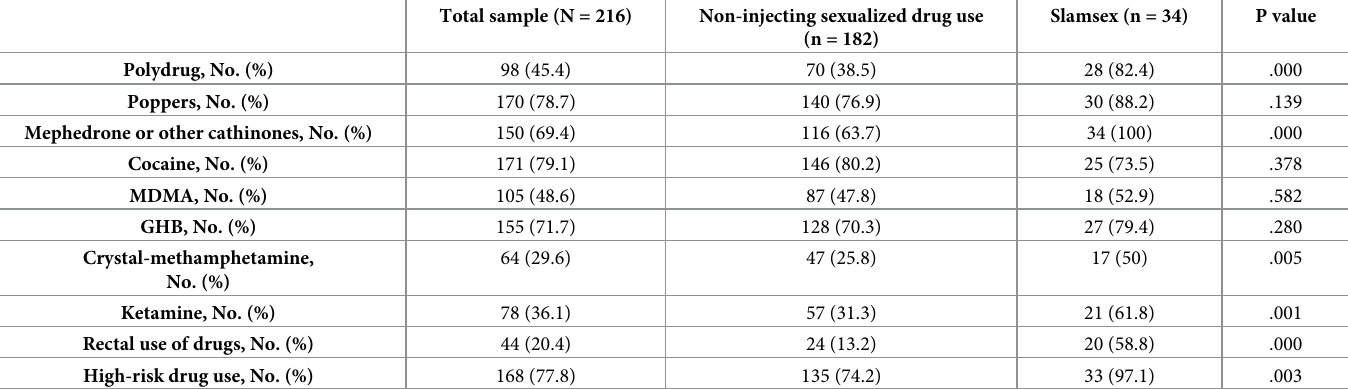
Comparisons based on the type of drug used in both groups of participants are shown in Table 1. Participants who engaged in slamsex had higher rates of polydrug use (three or more drugs per session) and more frequently used mephedrone and other cathinones, crystal-meth, and ketamine. They were also more likely to administer the drugs rectally and had higher rates of high-risk drug use behaviors, such as sharing needles and other drug paraphernalia. Symptoms related to drug abuse/dependence and severe psychopathological symptoms associated with the practice of slamsex and non-injecting sexualized drug use are shown in Table 2. The drugs most frequently injected intravenously were mephedrone and other cathinones (94.1%), followed by ketamine (17.6%), crystal-meth (5.9%), and cocaine (5.9%). Participants who engaged in slamsex had a significantly higher percentage of sexual risk behaviors than those who engaged in non-injecting sexualized drug use, as follows: fisting (73.5 vs. 38.5%, P = .001), fisting without a glove (67.7 vs. 28%, P = .001), condomless sexual relations (93.1 vs. 48.3%, P = .001), and more than 20 sexual partners in the previous 6 months (70 vs. 39.6%, P = .002). As for STIs, people who had engaged in slamsex more often had gon- orrhea (61.8 vs. 43.4%, P = .049), syphilis (88.2vs. 62.6%, P = .004), and hepatitis C (61.8% vs. 18.1%, P = .000) than people who engaged in non-injecting sexualized drug use. A self-reported current psychiatric disorder was more common among participants who engaged in slamsex than in those who engaged in non-injecting sexualized drug use. The con- ditions reported were as follows: depressive disorder (61.8 vs. 28%, P = .0001), anxiety disorder